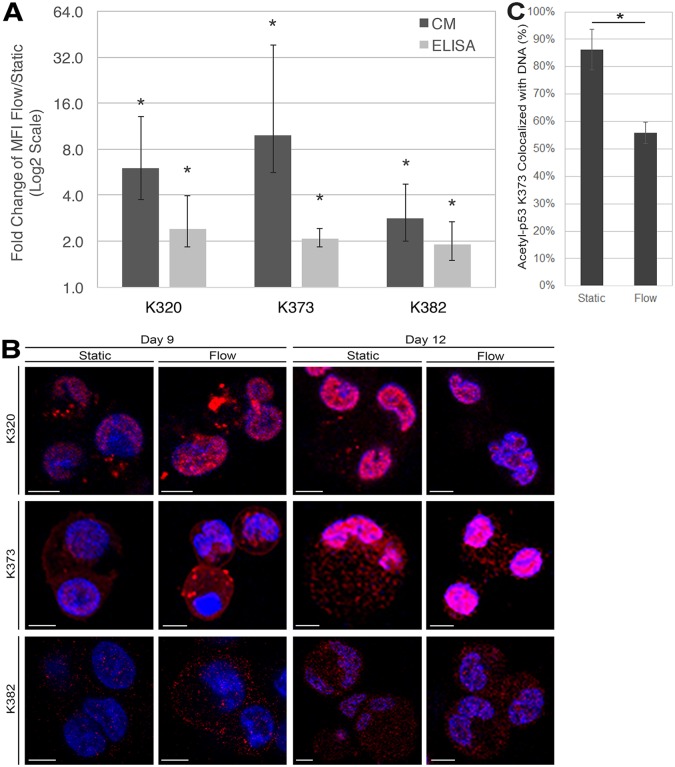
Shear flow alters p53 acetylation and sub-cellular localization in Mks.A, Fold change of mean fluorescence intensity (MFI) of acetyl-p53 expression for Lysine (K) 320, K373, and K382 in static and flow d9 Mks. Quantification was achieved using quantitative confocal microscopy (dark gray) and ELISA (light gray). One sample t-test, *p < 0.05, n = 3 (biological replicates) for CM, n = 4 for K373/K382 ELISA, n = 5 for K320 ELISA; error bars: SEM. B, Confocal microscopy of d9 and d12 Mks with immunofluorescent staining probing for acetyl-p53 (red), DAPI (blue), and co-localization (pink). C. Co-localization analysis from B on K372-acetyl-p53 (red) with nucleus (blue, DAPI) of d12 Mks under static or shear flow condition.